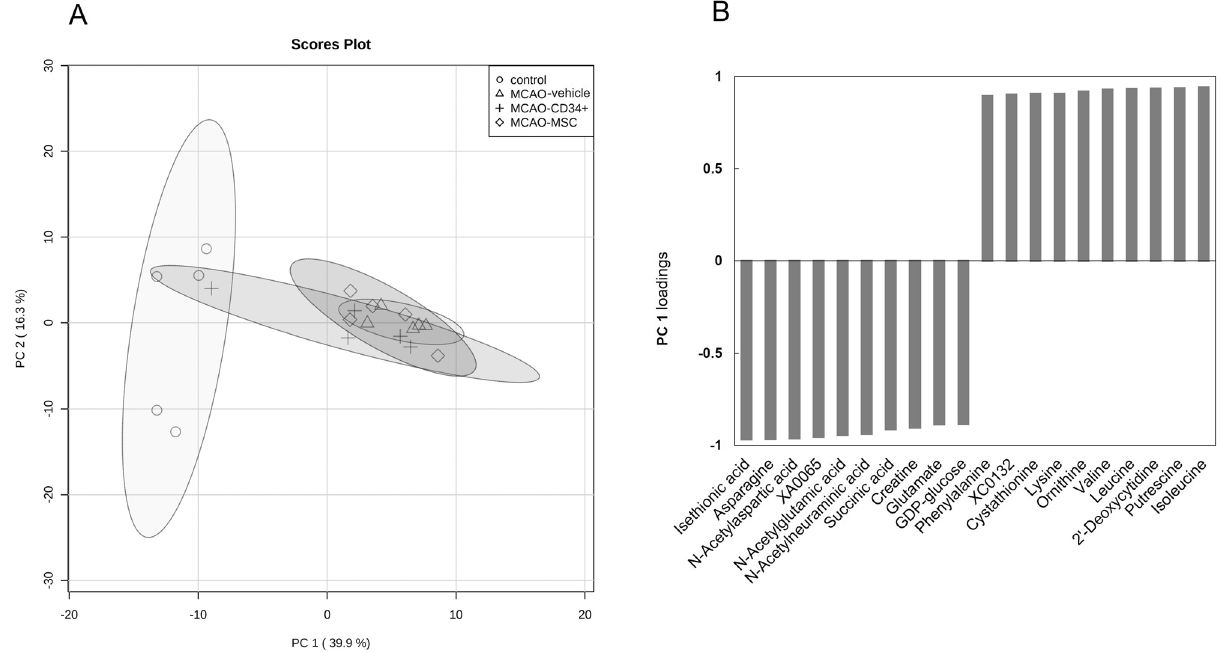
Figure 2. Principal component analysis of cerebral metabolomic changes 72 h after MCAO vs no surgery. CE-TOF MS data for 151 detected metabolites were subjected to principal component analysis after being split into four groups. ( A ) Score plot showing that the groups were well divided between the control (circle) and MCAO groups, excluding one outlier in the MCAO-CD34 + cell group (cross), according to the variation of principal component (PC) 1 (X-axis). ( B ) PC1 loading column plot of the top 20 metabolites. The listed metabolites strongly contributed to PC1, and vertical gray bars are distances in multivariate space between the average metabolite vectors for each